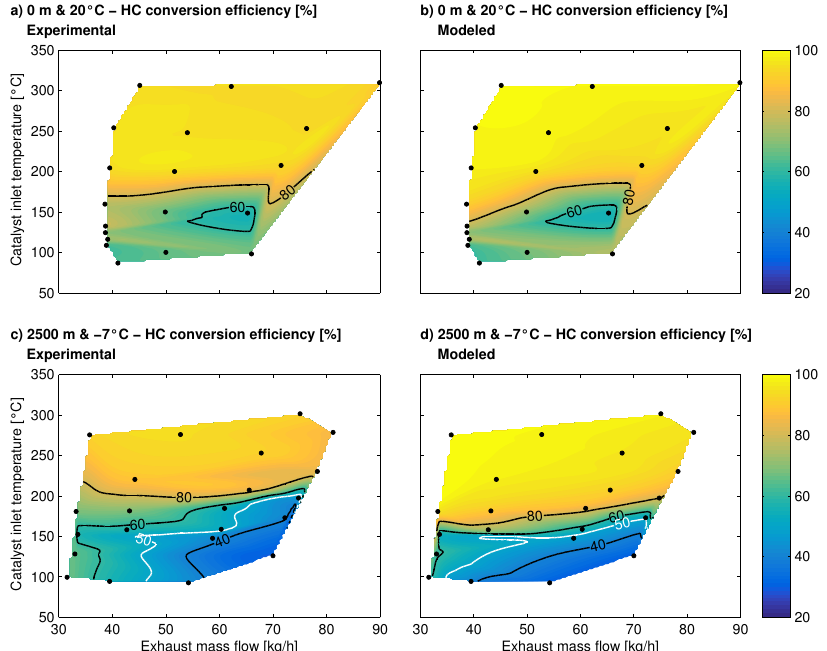
Figure 5. HC conversion efficiency as a function of the exhaust mass flow and catalyst inlet tempera- ture: ( a ) experimental results at 0 m and 20 ◦ C; ( b ) modeled results at 0 m and 20 ◦ C; ( c ) experimental results at 2500 m and − 7 ◦ C; and, ( d ) modeled results at 2500 m and − 7 ◦